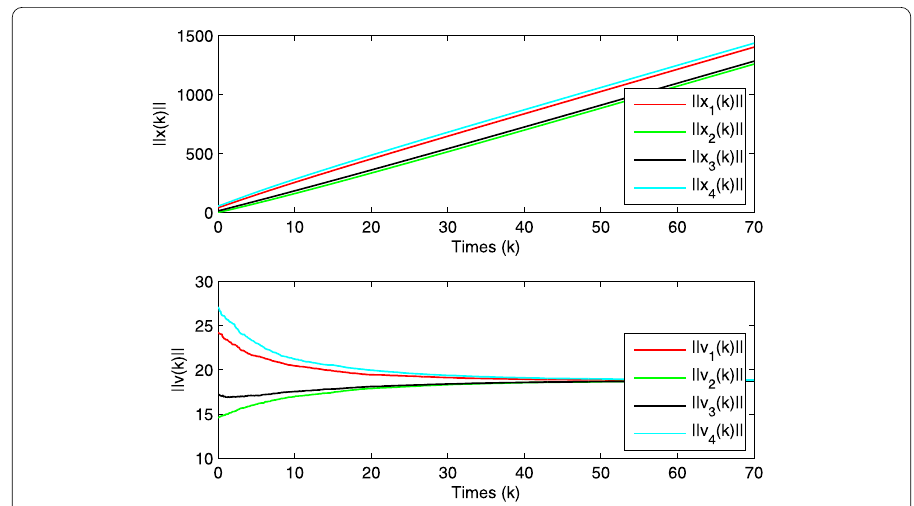
Figure 11 The norms of position and velocity trajectories with α = 0.5 in Case 4